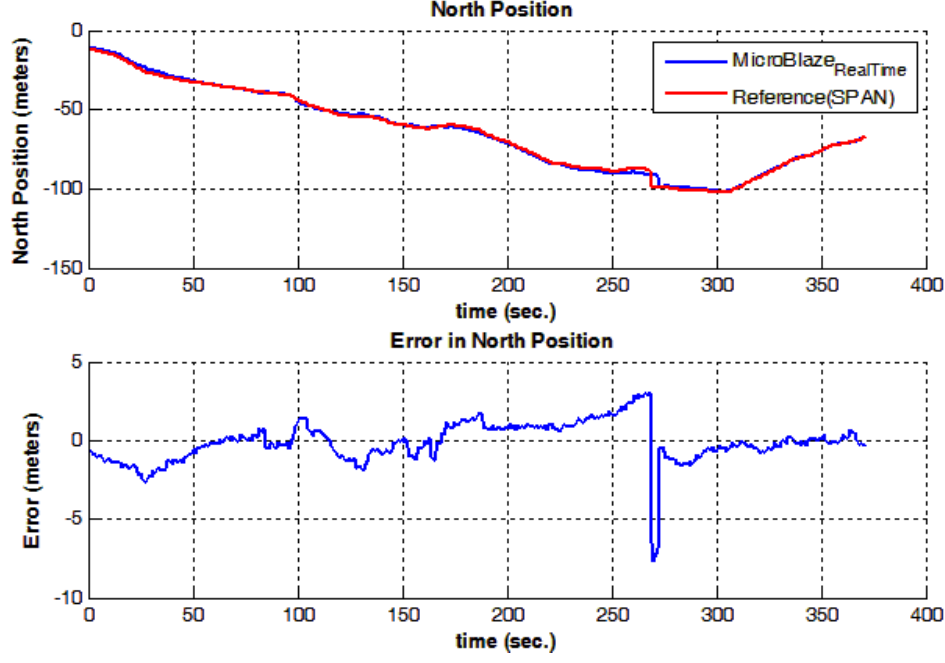
Figure 18. North Position Solution and Error in North Position between the Real-time and Reference Solutions during Trajectory (3).